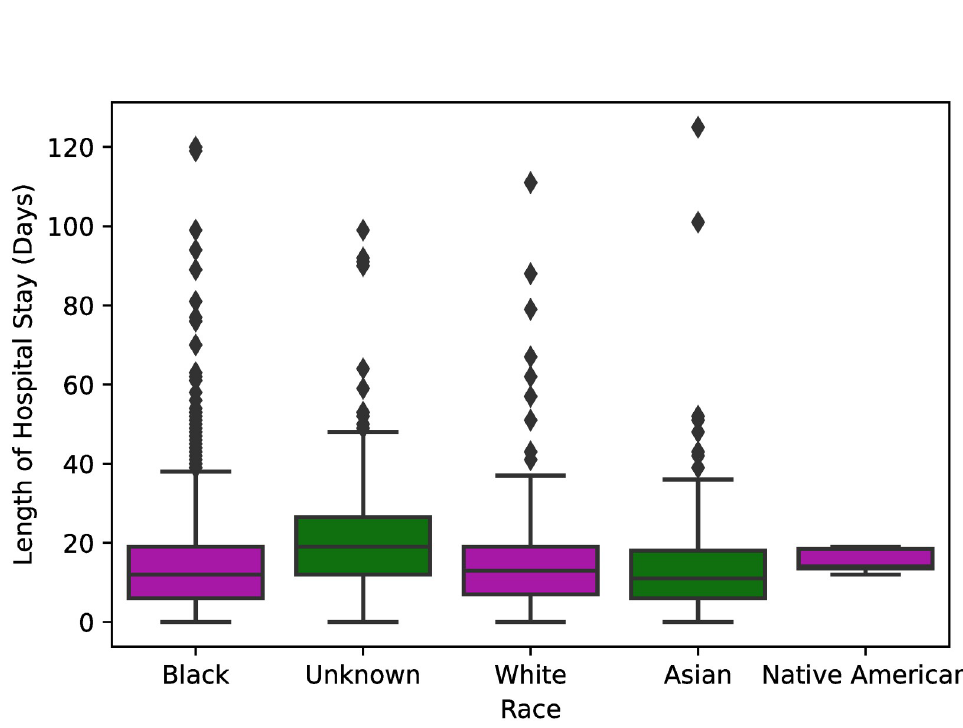
Fig 6. Box plot showing the length of hospital stay per race of the hospitalized COVID-19 patients. One-way ANOVA was used to estimate a significant p-value < 0.001 for those variables.